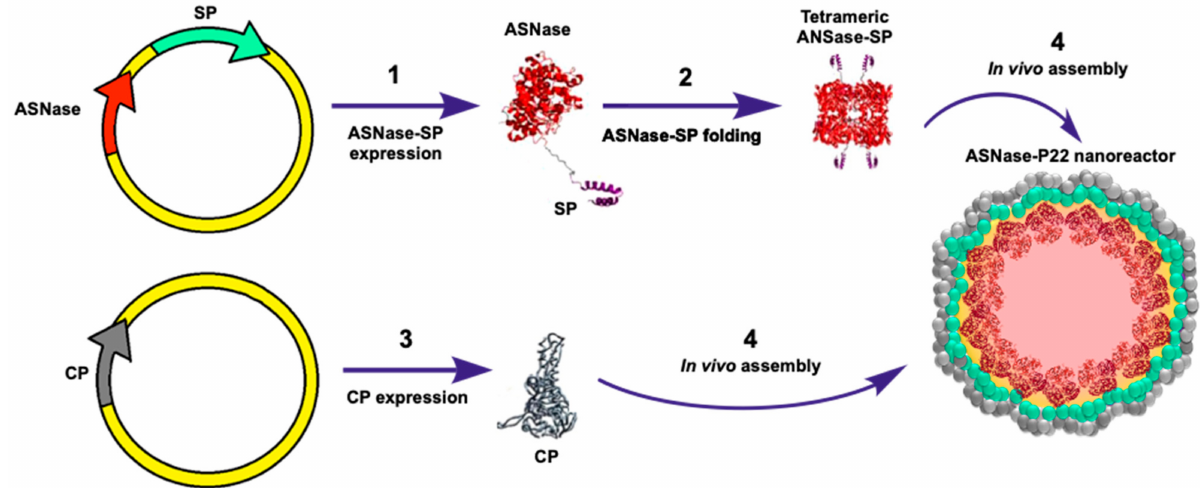
Figure 1. ASNase-P22 nanoreactors. Genetically directed ASNase encapsidation in P22-based virus-like particles (VLPs): ( 1 ) Cloning and ASNase-SP chimeric protein expression. ( 2 ) Folding of tetrameric enzyme; ( 3 ) Capsid protein expression; and ( 4 ) VLP assembly. ASNase: Asparaginase; SP: Scaffold protein; CP: Capsid